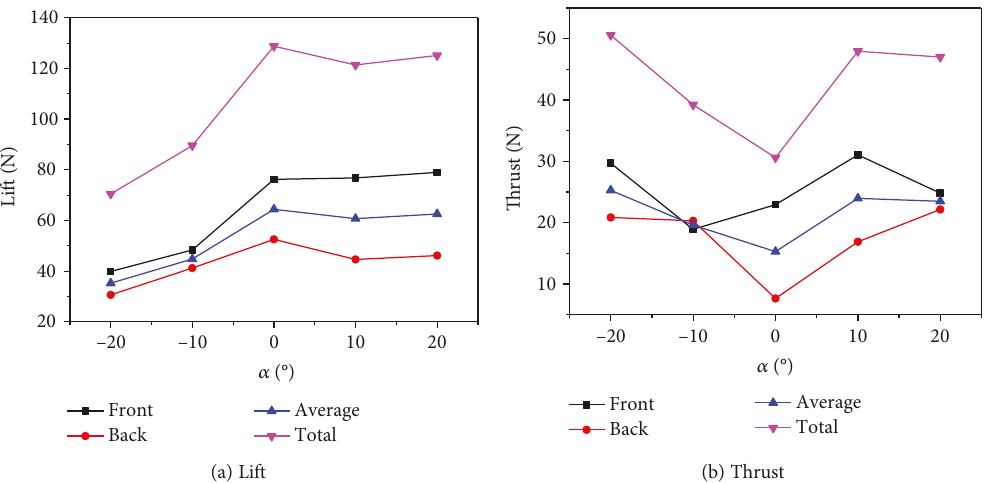
Figure 16: Curve of the lift and thrust of the front and rear fan wings when the front and rear wings have the same installation